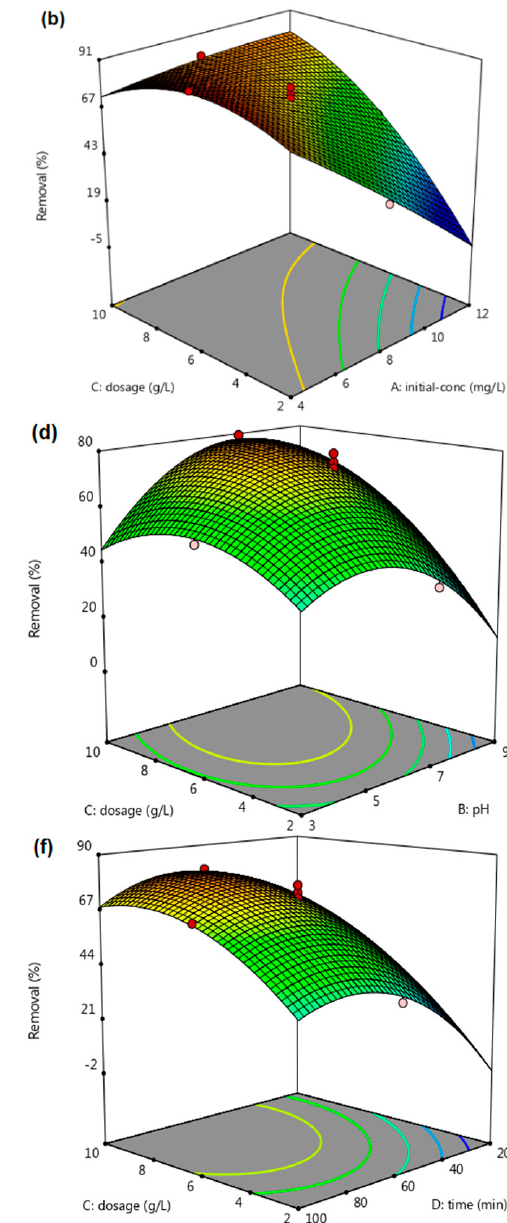
Figure 6. 3D plots of fluoride adsorption by the SC adsorbent showing the interaction effect of ( a ) F − concentration and pH, ( b ) F − concentration and dosage, ( c ) F − concentration and time, ( d ) pH and dosage, ( e ) pH and time, and ( f ) dosage and time.